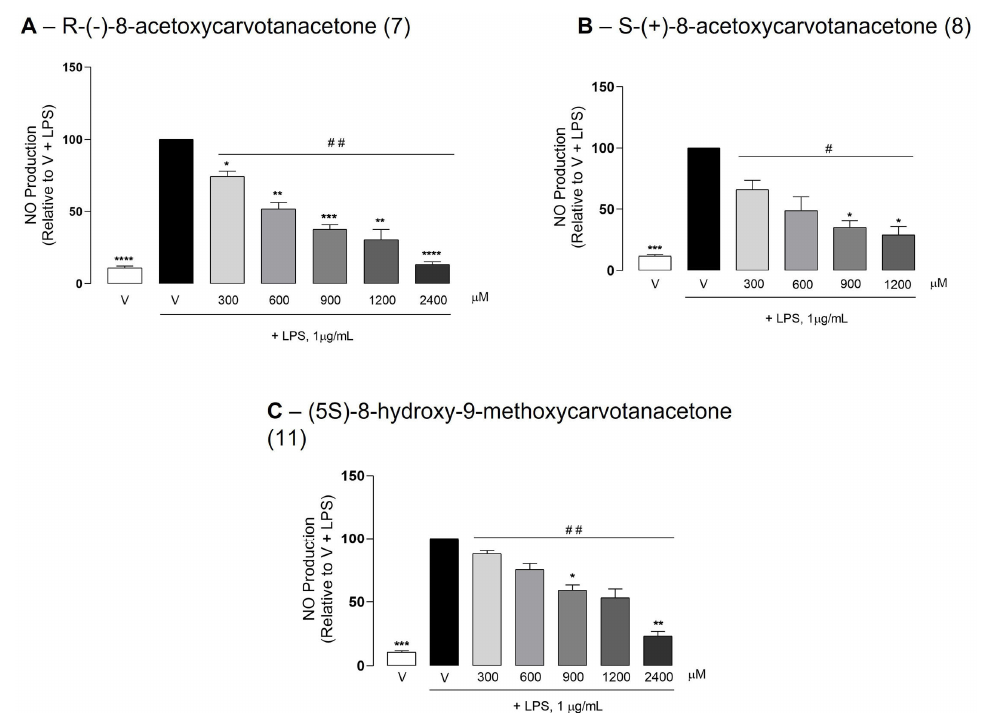
Figure 2. Effect of the test compounds on NO production. Raw 264.7 macrophage cultures were treated with the selected concentrations of the test compounds or the vehicle (0.1% DMSO) for 1 h followed by the addition of LPS and further incubation for 18 h. Each column represents the mean ± SEM of three independent experiments. * p < 0.05, ** p < 0.01, *** p < 0.001 and **** p < 0.0001 relative to LPS ‐ treated cells (V+LPS). # p < 0.05 and ## p < 0.01 among all the concentrations tested.